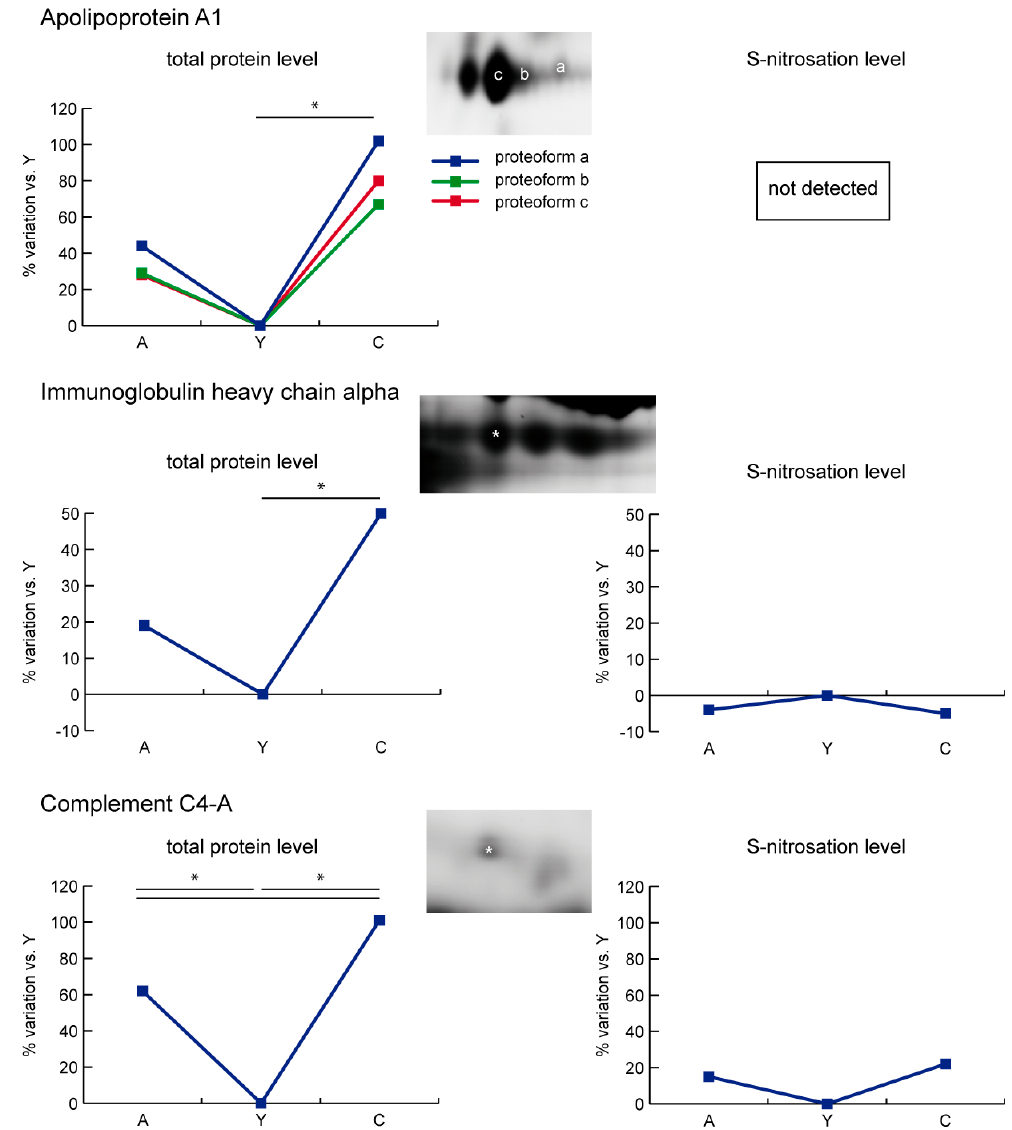
Figure 7. Line charts illustrating apolipoprotein A1 (APOA1), immunoglobulin heavy chain alpha (IGHA1), and complement C4-A (C4A) proteoform abundance and S-nitrosation level variations (%) in sera of aged (A) and centenarian (C) compared to young (Y) women. Proteins were divided according to the statistical significance of the test (* = significant difference, ANOVA and Tukey, n = 6 (2-D DIGE) or n = 9 (Nitro-DIGE), p -value < 0.01).